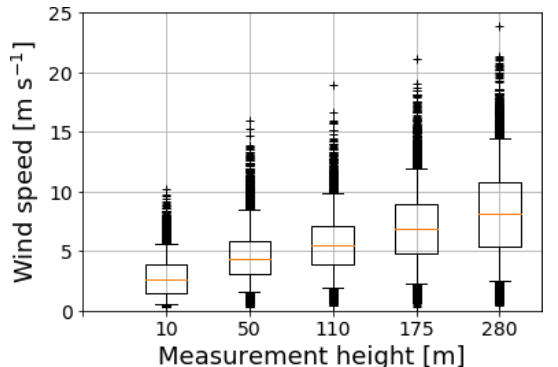
Figure A1. Boxplots of hourly wind speed data for the year 2018 from the Hamburg weather mast. Red lines indicate median values; lower and upper whiskers end at 5th and 95th percentile, respec- tively.